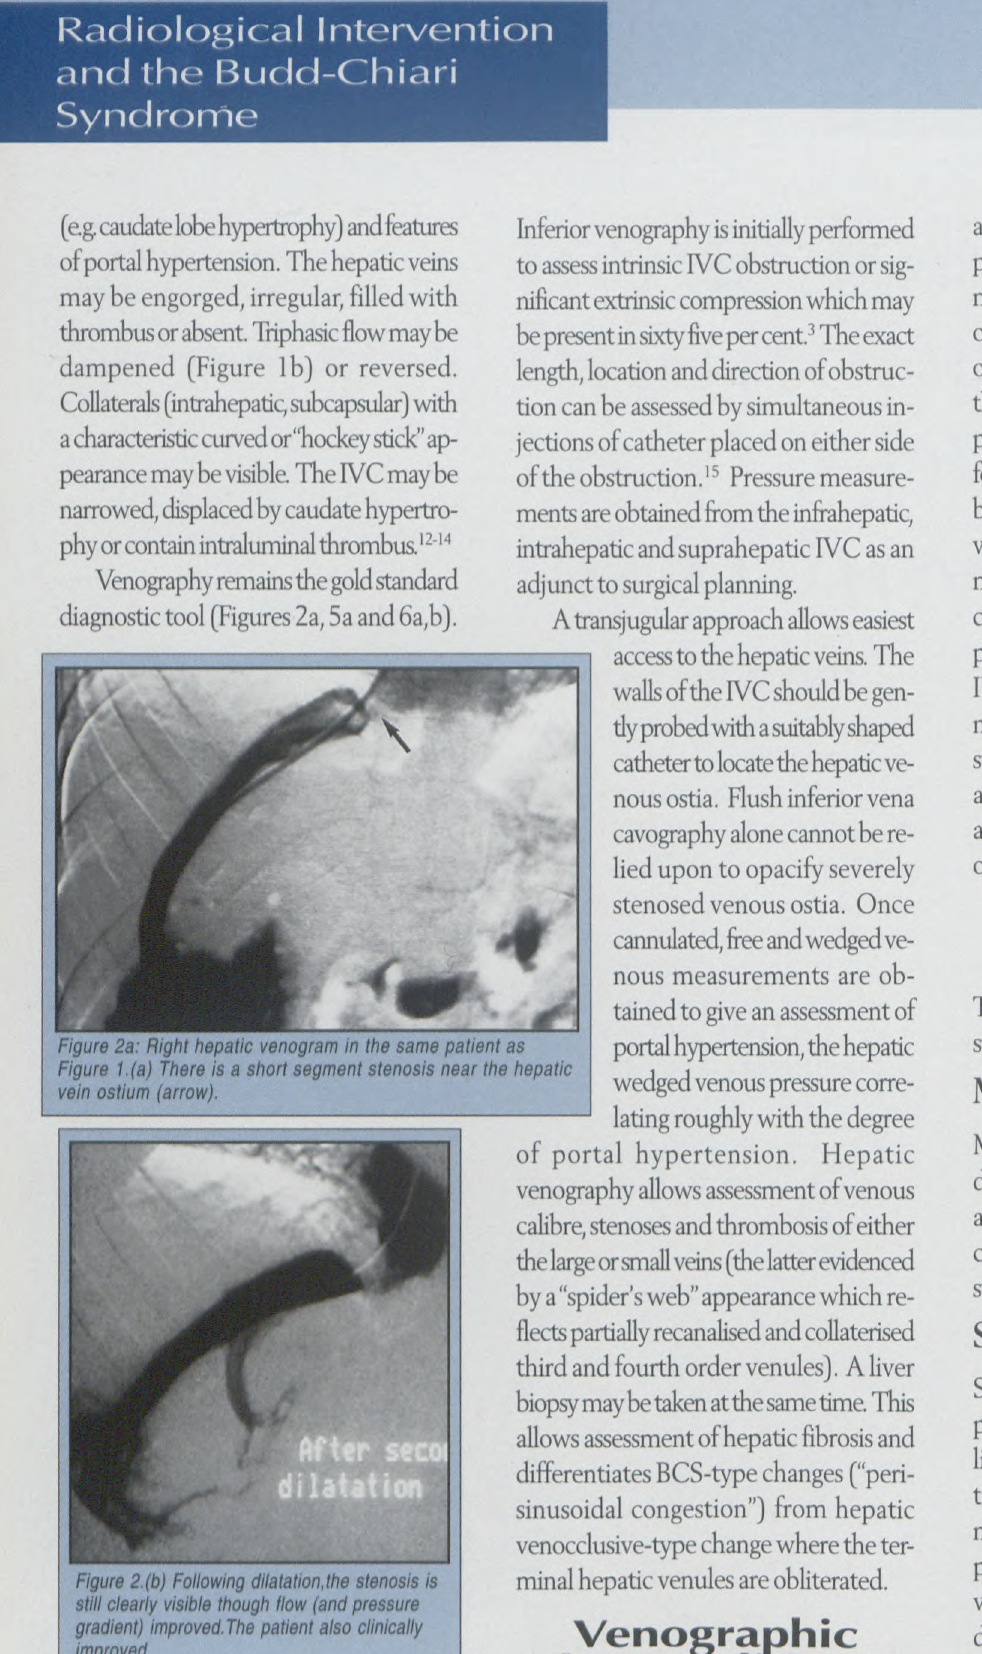
Figure 2.(b) Following d/latation,the stenosis is stili clearly visIble though flow (and pressure gradIent) improved. The patient also clinIcally